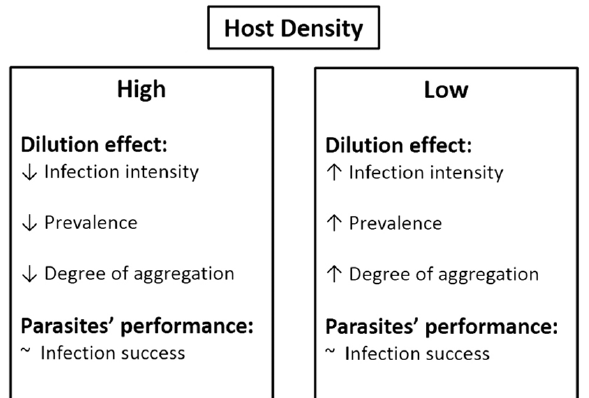
Fig. 1. Predicted effects of differing host densities on infection parameters. Infection intensity is the mean num- ber of sea lice per fish. Prevalence is the proportion of infected fish. Degree of aggregation refers to the parasite distribution among host individuals, and was assessed using Ives’ (1991) measure of intraspecific aggregation J, defined as J A = V A / N 2 − 1 / N, where V A is the variance, and N is the mean number of sea lice per fish. Infection success is the percent of infection intensity out of the total number of parasites available per host during infec- tion (i.e. infective dose). We hypothesized that high host density will decrease infection intensity, prevalence and degree of aggregation due to the ‘dilution effect’, but would have no effect on infection success, a